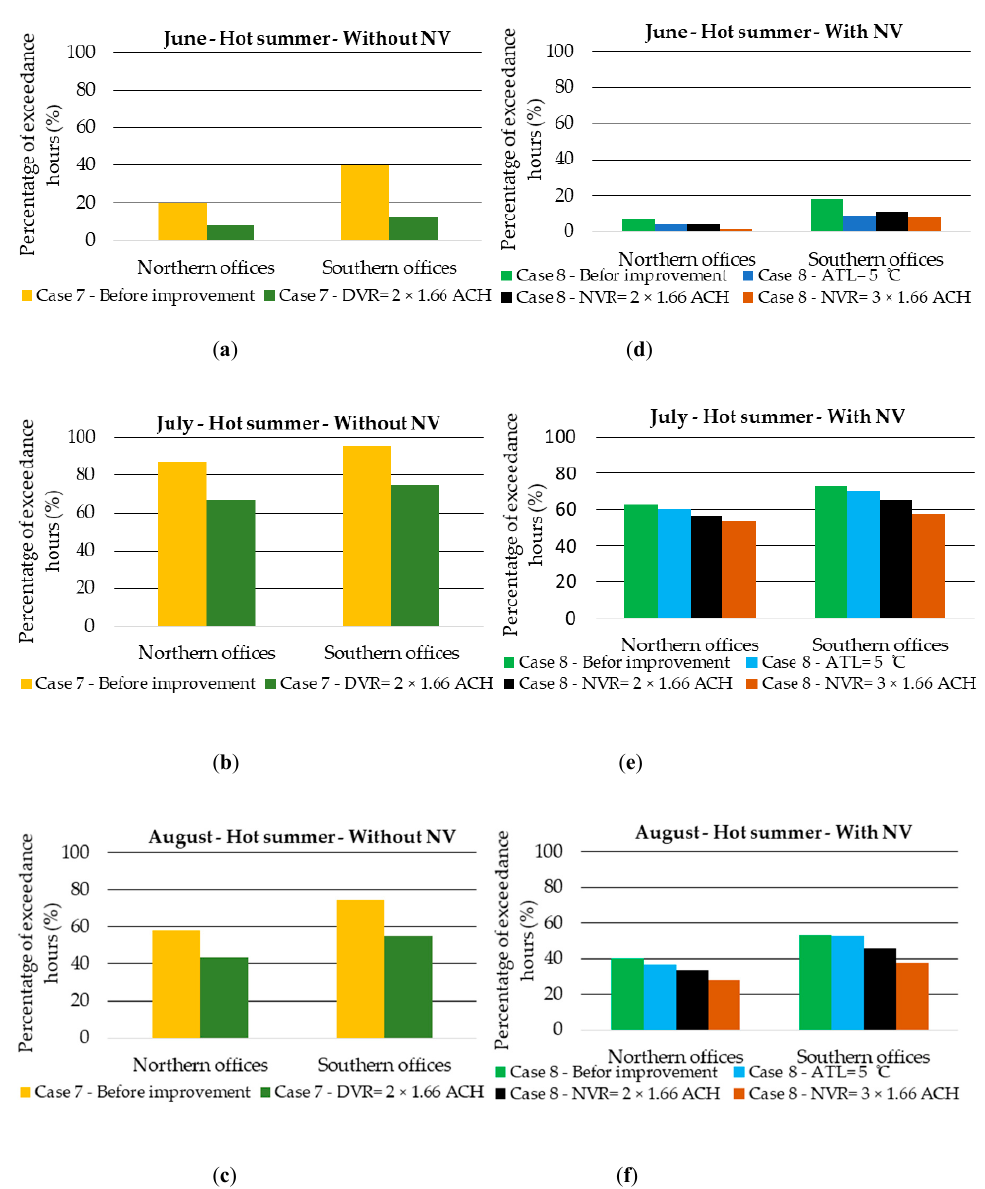
Figure 9. Percentage of exceedance hours in o ffi ces for thermal comfort improving measures for ( a – c ) case 7 and ( d – f ) case 8 during the hot summer of 2018. Cases 7 and 8: All doors always open. Southern o ffi ces represent o ffi ces with southeast orientation with higher internal solar gains compared to other o ffi ces. Northern o ffi ces represent all other o ffi ces excluding the open-plan o ffi ce. DVR: Daytime Ventilation rate, NVR: NV Rate, ATL: Ambient Temperature